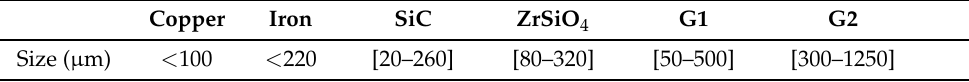
Table 2. Size distribution, in µ m, of six of the components used in the formulation of